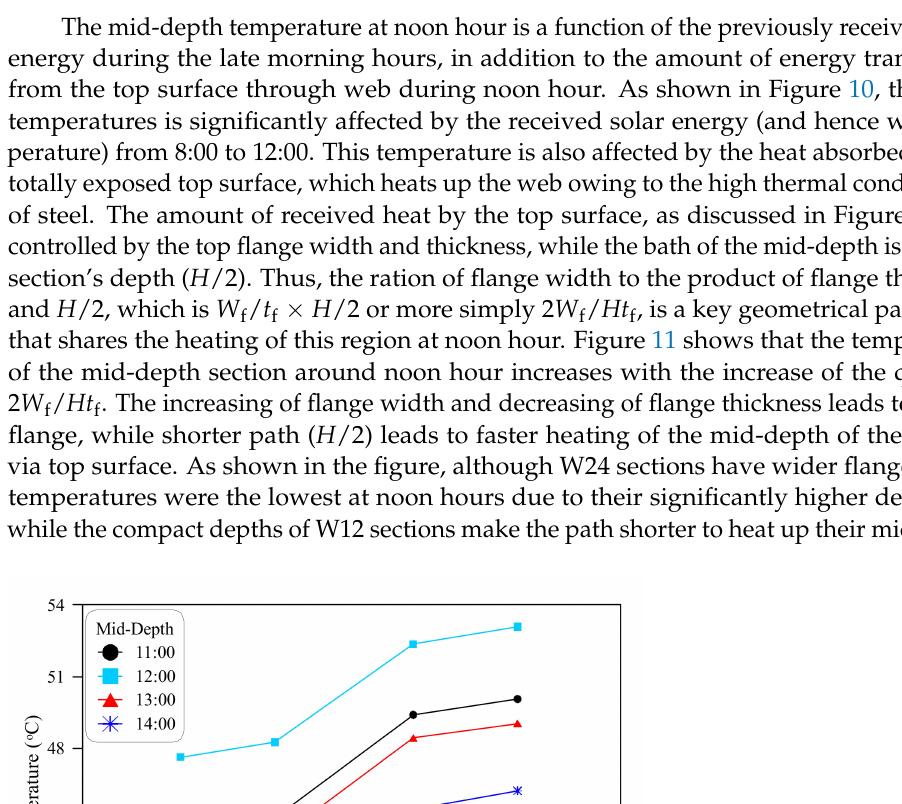
Figure 10. Temperature-time relations for the mid-depth of the steel sections.